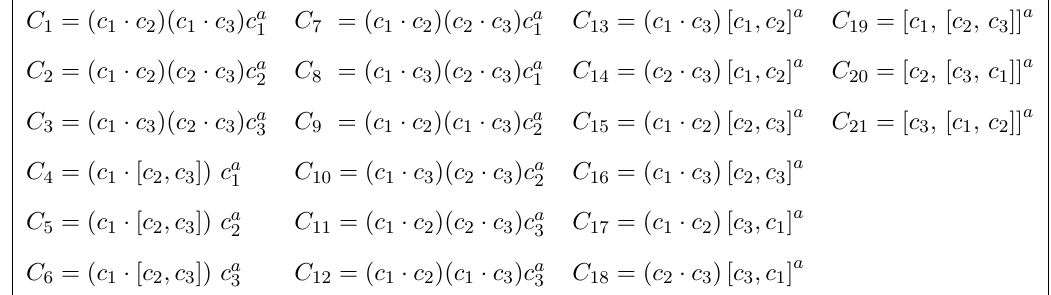
Table 1 . List of the color numerators relevant for radiation at next-to-leading order. The last three satisfy Jacobi identity C 19 + C 20 + C 21 =